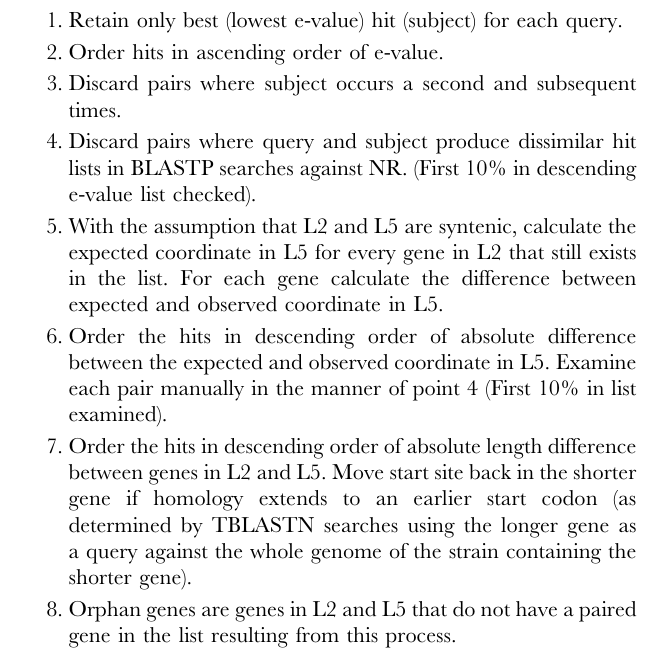
Gene Functiona Alignment Protein